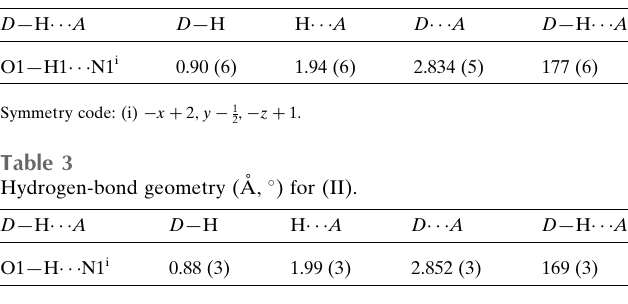
Table 2 Hydrogen-bond geometry (A˚ , (cid:2) ) for (I).